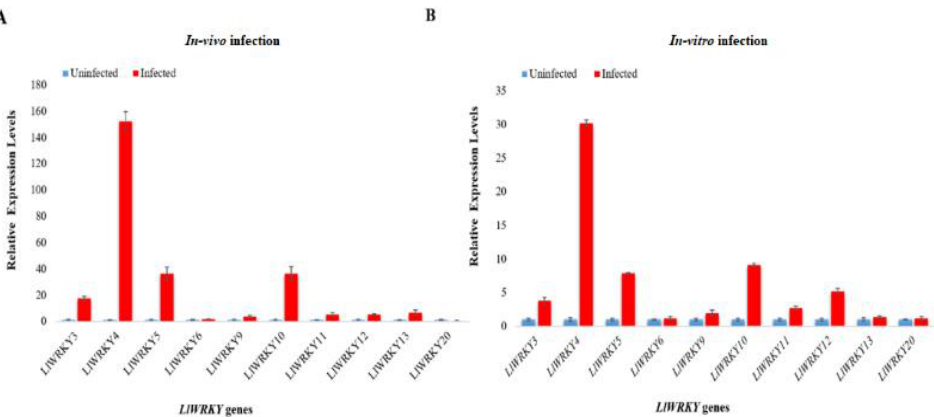
Figure 4. Comparative expression patterns of the selected LlWRKY genes in response to Botrytis elliptica infection investigated under ( A ) in vivo and ( B ) in vitro conditions. Error bars indicate the standard error of three biological replicates and the expression levels were normalized against the level of actin .